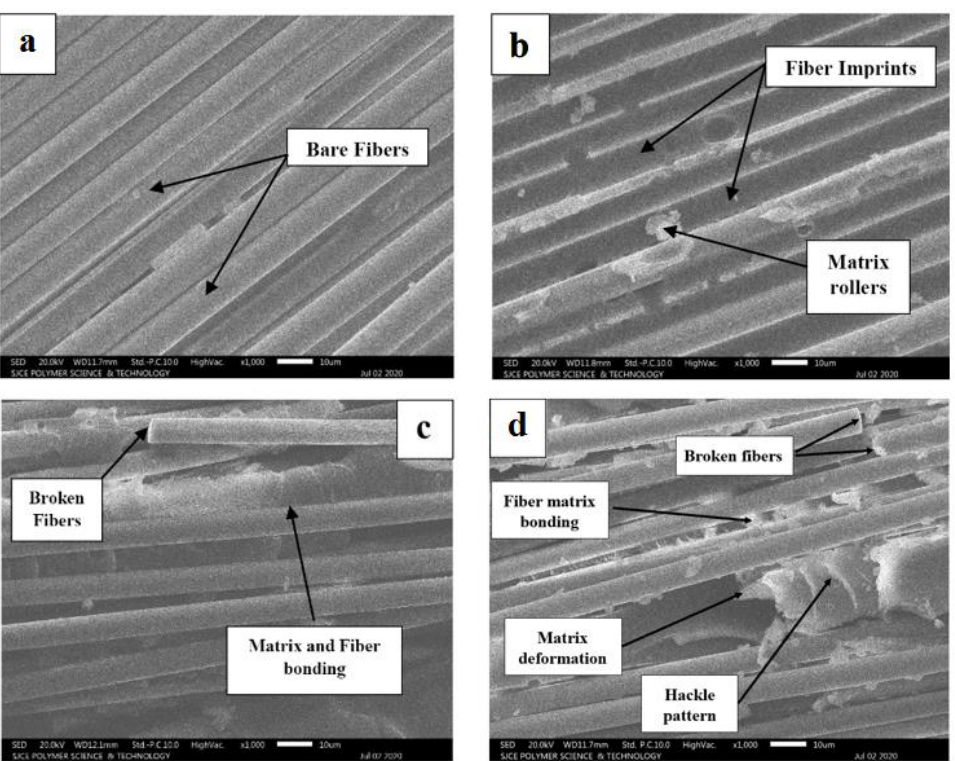
Figure 12. SEM micrographs from mode-I fractured delaminated surfaces of ( a ) GE-RT ( b ) GE-90-6 ( c ) GE-135-6 ( d ) GE-180-6.